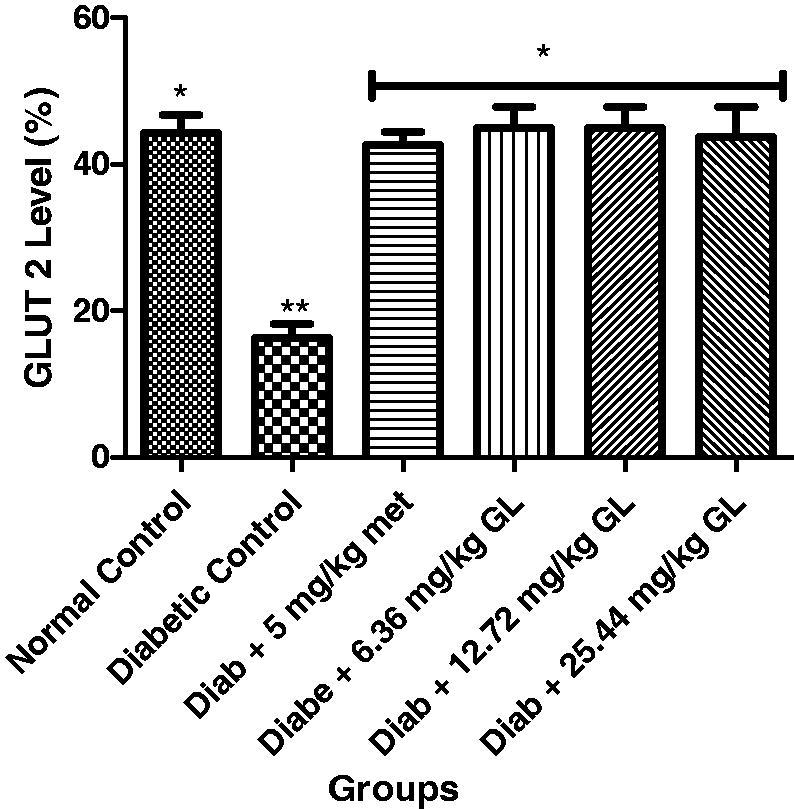
Glucose transporter (GLUT-2) level after administration aqueous extract of G. latifolium leaf. Values are expressed as mean ± standard deviation (SD) of eight replicates. Bar with the same * are not significantly different at p > 0.05. Bar with different * are significantly different at p < 0.05. Normal control: non-diabetic control; met: metformin; Diab: diabetic; GL: Gongronema latifolium leaf.